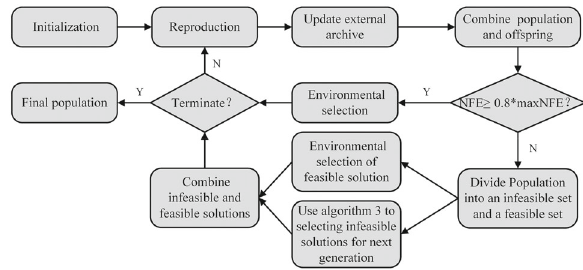
Fig. 1 Flowchart of the proposed